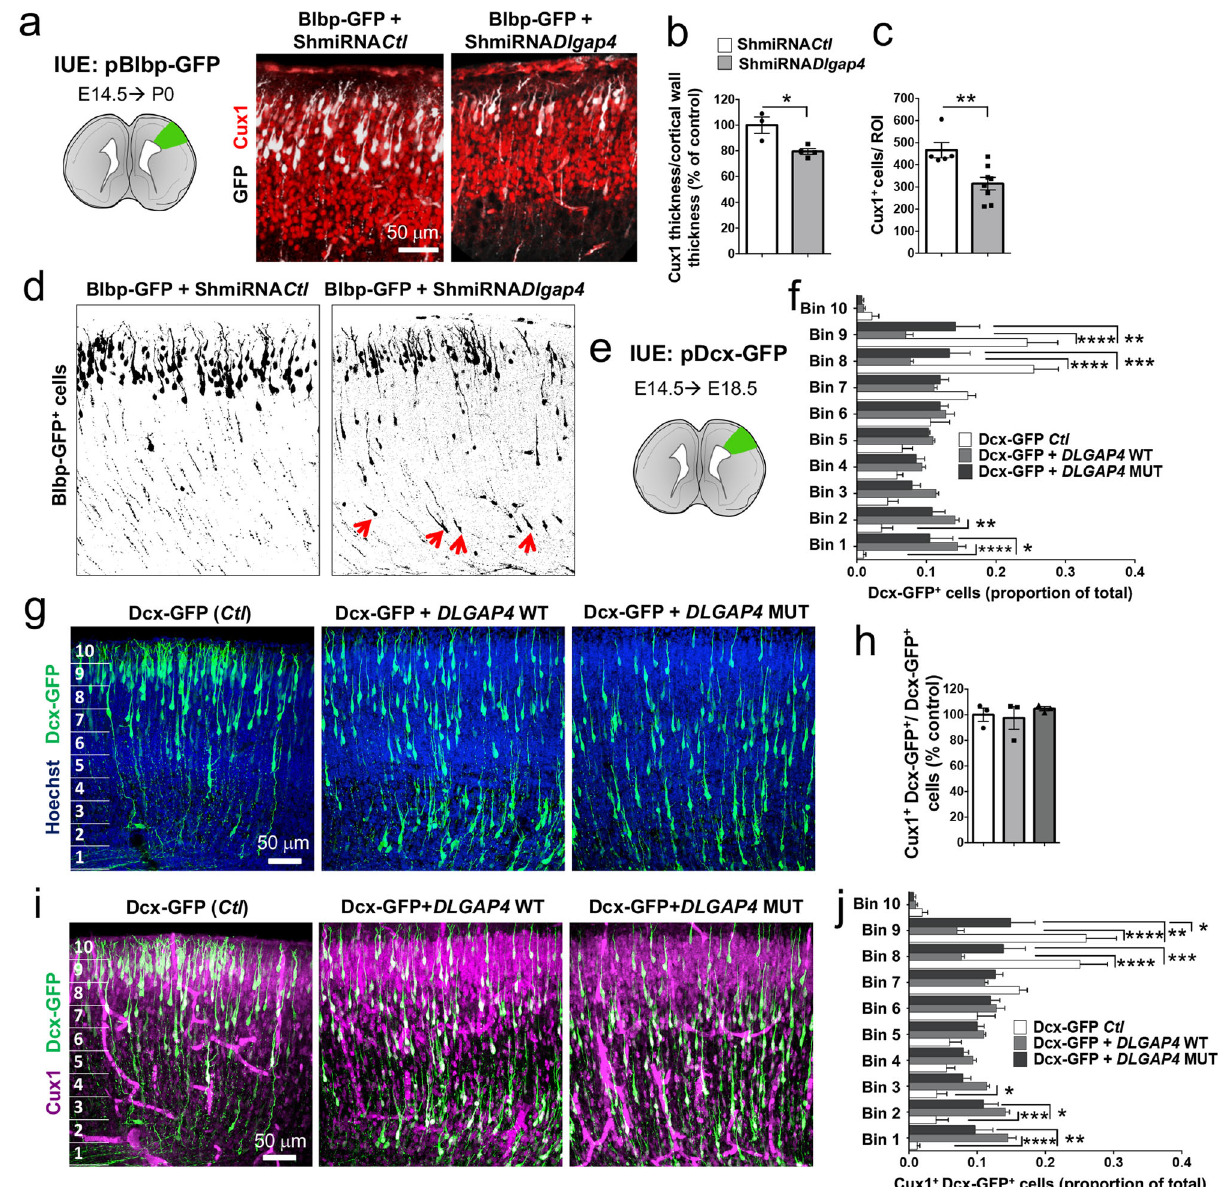
Fig. 8 Dlgap4 KD or OE leads to slowed neuronal migration. a Left: Schematic representation of the electroporated ROI at P0. Right: Representative Cux1 (red) labeling and Blbp-GFP (white) in Ctl and Dlgap4 KD brains at P0. b Cux1 thickness relativized to cortical wall thickness ( n = 3 Ctl, n = 4 Dlgap4 KD brains from 2 litters per condition). Quanti fi cation data represent relativized individual values, mean ± SEM (two-sided unpaired t -test, *p = 0.018). c Total Cux1 + cells per ROI ( n = 5 Ctl, n = 8 Dlgap4 KD brains from 2 litters per condition). ROI: 135 μ m height × 370 μ m width. Quanti fi cation data represent individual values, mean ± SEM (two-sided unpaired t -test, **p = 0.0066). d GFP + cells are still migrating below the CP in the KD at P0 (e.g., red arrows). e Schematic representation of the electroporated ROI at E18.5. A Dcx-GFP reporter promoter vector was co-electroporated with a pDcx- DLGAP4 WT-Flag- ires-GFP or pDcx- DLGAP4 MUT-Flag-ires-GFP construct. f Quanti fi cation of Dcx-GFP + cells along the cortical wall divided in 10 bins. Two-way ANOVA followed by Sidak ’ s test was performed ( n = 3 brains from 2 litters per condition). Relativized mean values ± SEM are shown. Two-way ANOVA, Interaction Bin x OE condition, F 9, 60 = 16.11, p < 0.0001; * p = 0.014, ** p < 0.005, *** p = 0.0004, **** p < 0.0001. g Representative images of OE experiments targeting speci fi c neuronal migration after IUE showing Dcx-GFP + (green) cell distribution and Hoechst staining. h Total Cux1 + Dcx-GFP + / Dcx-GFP + cells did not change along conditions. Relativized mean and individual values ± SEM are shown. One-way ANOVA followed by Tukey ’ s test, F 2, 6 = 0.39, p = 0.70. i Representative images of OE experiments showing Cux1 + (magenta) and Dcx-GFP + (green) cell distribution. j Quanti fi cation of Cux1 + Dcx-GFP + /Dcx- GFP + cells along the cortical wall divided in 10 bins. Two-way ANOVA followed by Sidak ’ s test was performed ( n = 3 from 2 litters per condition). Relativized mean values± SEM are shown. Two-way ANOVA, Interaction Bin × OE condition, F 9, 60 = 16.63, p < 0.0001; * p < 0.05, ** p < 0.005, *** p < 0.001, **** p <